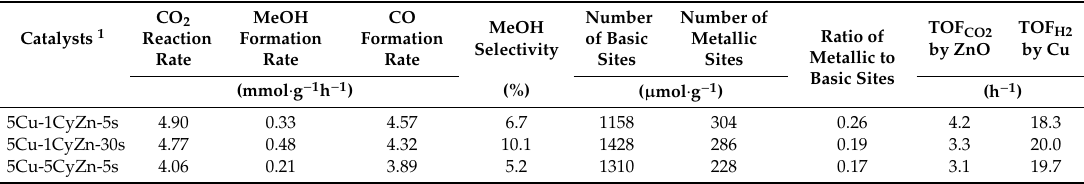
Table 6. Catalytic performance of the ZnO over-coated Cu / SiO 2